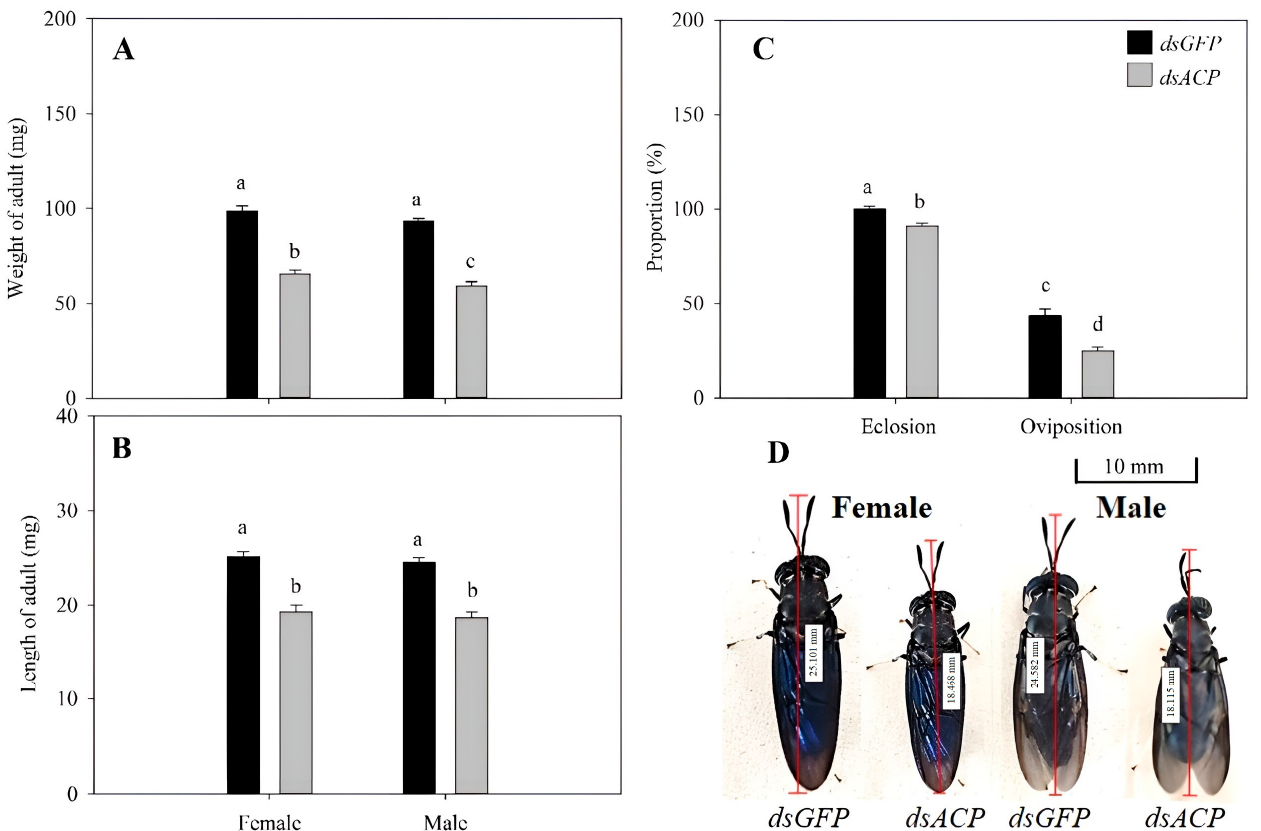
Figure 5. Changes in the body weight, length, eclosion, oviposition, and appearance in adults after the one-day-old 3rd instar larvae of H. illucen injected with 1.5 µL dsACP (2000 µg·mL − 1 ) grew to adults. ( A ): Changes in the weight of female and male adults. Y-axis values are the means of the average weight of adults. ( B ): Changes in the length of female and male adults. Y-axis values are the mean of the average length of adults. ( C ): Changes in the proportion of eclosion of adults and oviposition of female adults. Y-axis values are the means of the proportion of eclosion and oviposition. ( D ): Appearance changes of female and male adults. The pictures of adults were collected on the first day after molting. Every adult grew from a one-day-old 3rd instar larva of H. illucen injected with 1.5 µL dsACP (2000 µg·mL − 1 ). Mean ± SE was calculated from three biological replicates, and each biological replicate contained 50 one-day-old 3rd first instar larvae that grew to the adult stage. Bars marked with different letters indicate significant differences between treatment and control (Student’s t -test, p < 0.05).